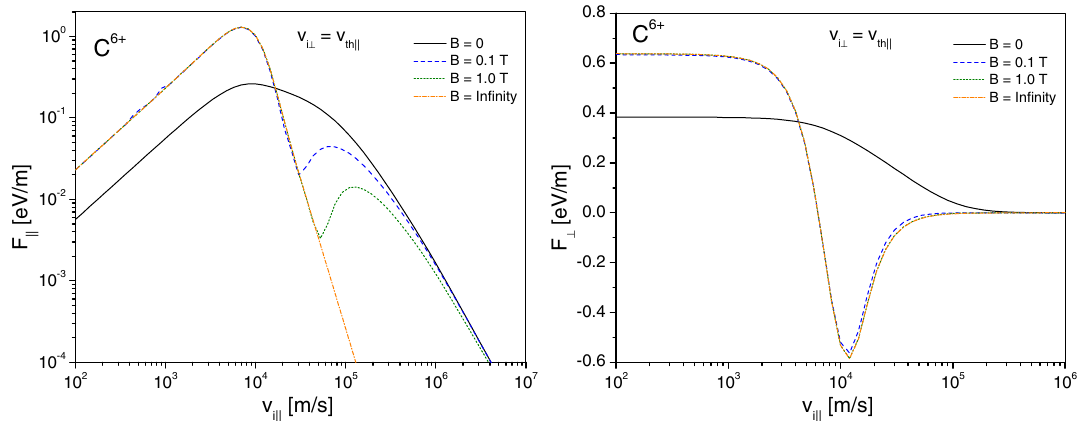
¼ v th ¼ 10 (cid:1) 2 eV ( T ¼ 10 2 T k but for T ? ? k ). Note that in the right panel the transverse force for i ?